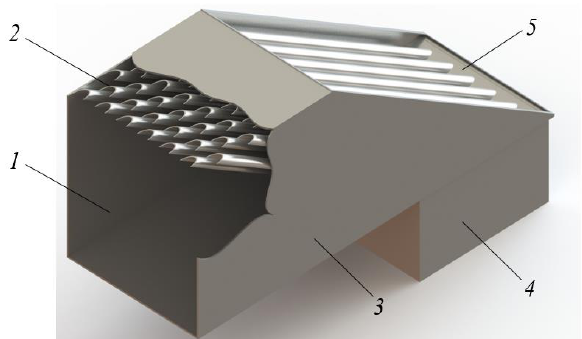
Figure 2. A separator with arc-shaped elements (a cross-sectional view): (1) the inlet for the gas contaminated by the catalyst; (2) rows of arc-shaped elements; (3) the body; (4) the hopper; and (5) the outlet for purified gas.